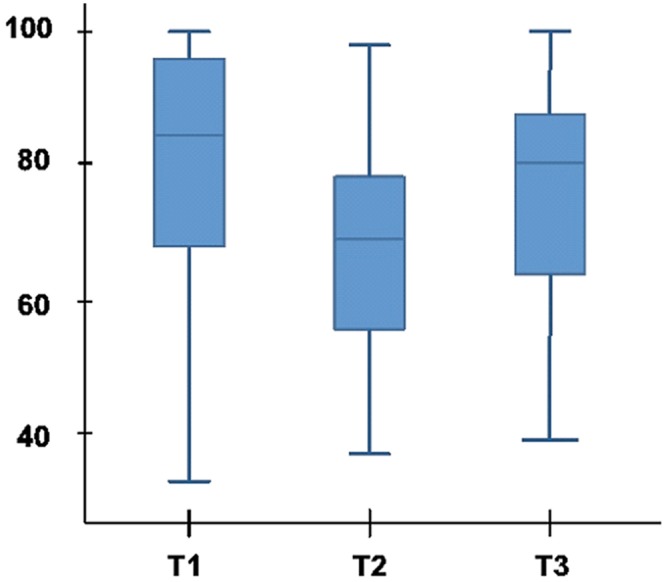
ANI values in study patients.